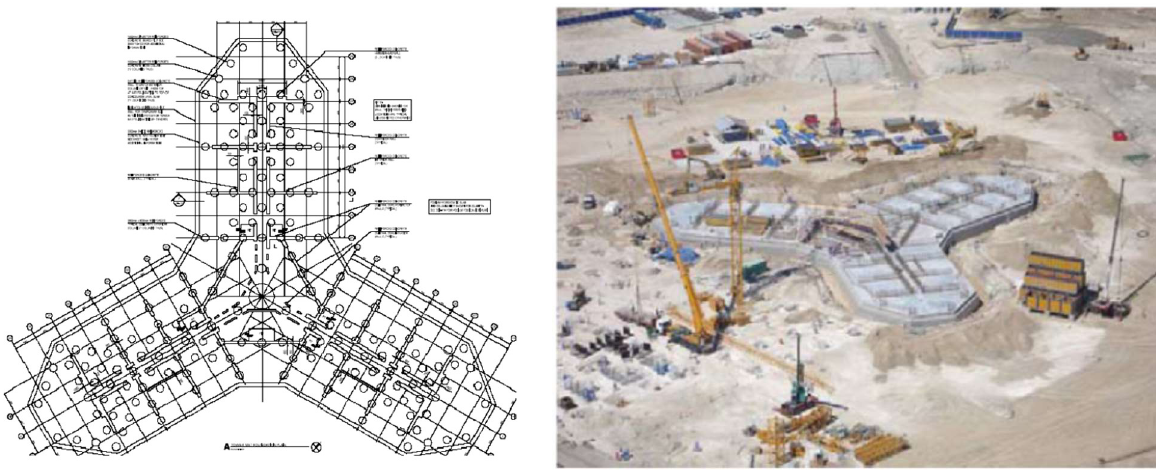
Figure 7. Tower raft foundation plan and photo of raft construction.Source: [6].